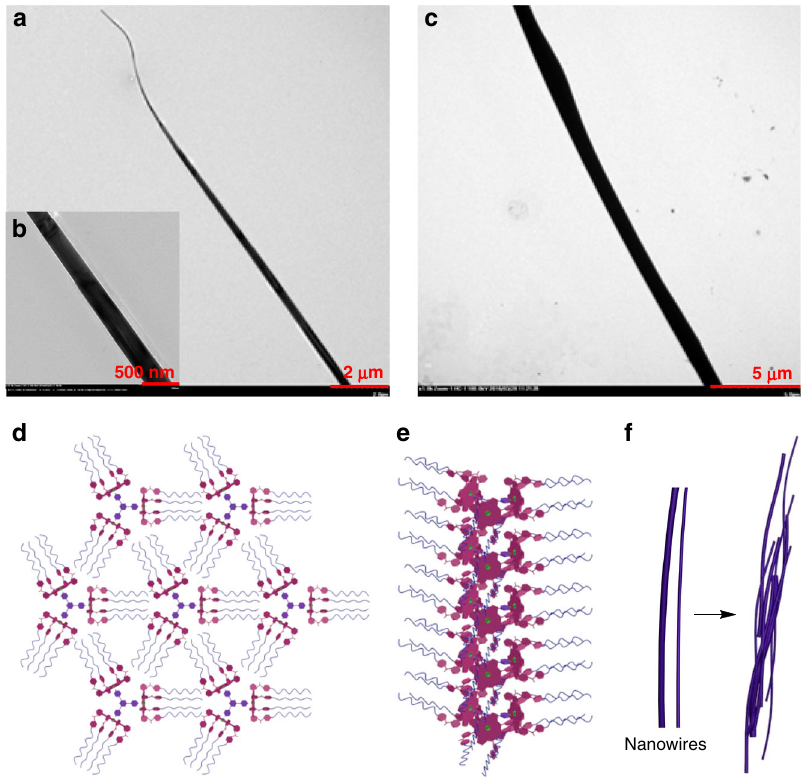
Fig. 8 TEM images of self-assemblies formed from 6 3 (cid:129) 10 . a , b TEM images of 6 3 (cid:129) 10 (1.00 × 10 − 3 M) in aqueous solution. c TEM image of 6 3 (cid:129) 10 (1.00 × 10 − 3 M) with the addition of 4 equiv n -Bu 4 NCl in aqueous solution. d Schematic representation of the cross section of the nanowires. e Stacking